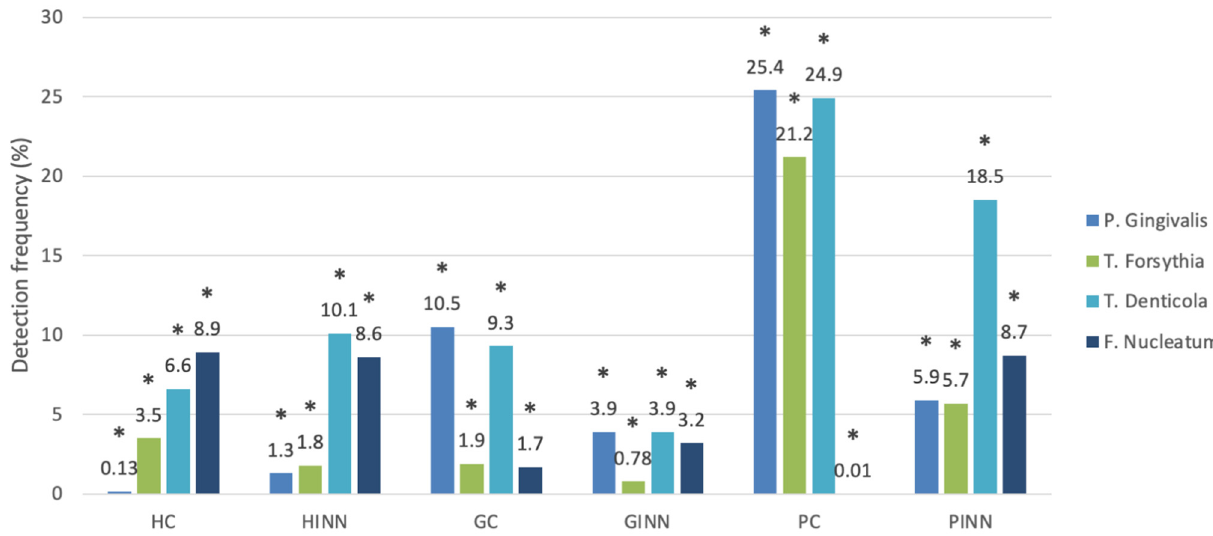
Figure 1. Bacterial detection frequencies of the four periodontal pathogens among the six study groups determined by real- time PCR. HC, healthy periodontium; HINN, subjects with healthy periodontium receiving isotretinoin (INN); GC, control subjects with gingivitis; GINN, generalized plaque-induced gingivitis; PC, control subjects with generalized periodontitis stage I; PINN, subjects with generalized periodontitis stage I receiving INN; *, statistically significant. Table 1. Sequence of primers used in quantitative real-time polymerase chain reaction. Product Size Species Sequence (5 ′ -3 ′ )